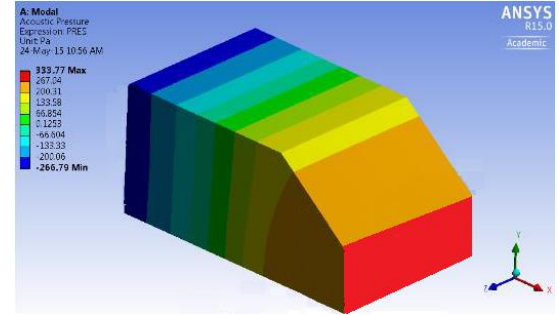
Fig. 3. Pressure distribution due to wheel house compartment